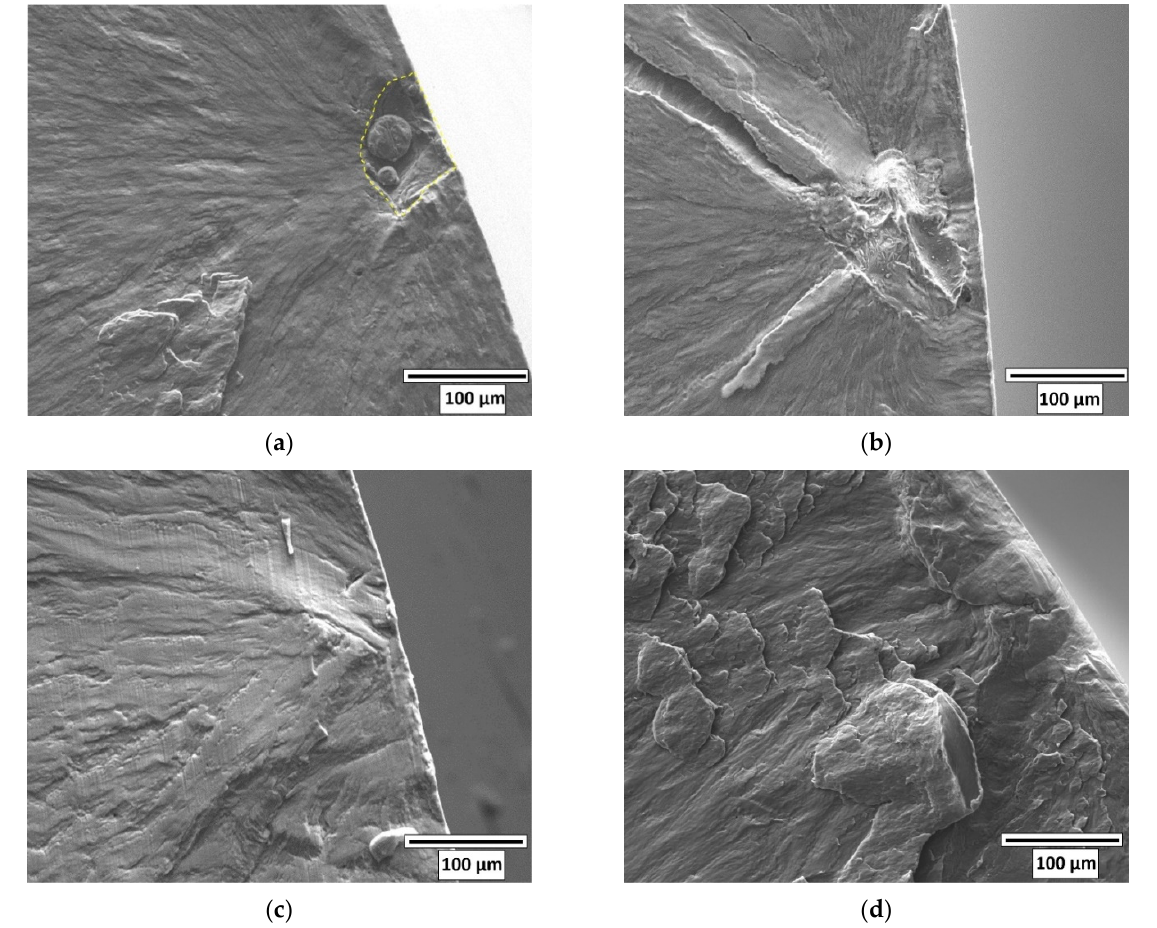
Figure 15. SEM images of fatigue fracture surfaces. Features presumed from observations to be responsible for the fatigue crack initiation: ( a ) lack-of-fusion ( 𝑁 (cid:3033) = 4.41 x 10 (cid:2873) cycles , √area = 104 μm ); ( b ) oxide ( 𝑁 (cid:3033) = 3.25 x 10 (cid:2874) cycles ); ( c ) and ( d ) indefinite discontinuities.